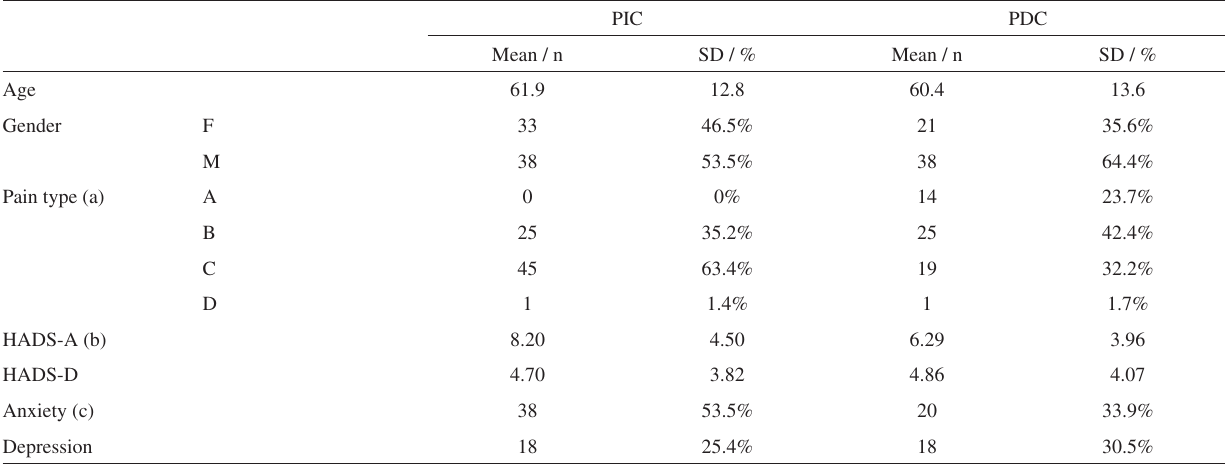
Table 2 - Chest Pain of Indeterminate Cause and Chest Pain of Determined Cause - Group